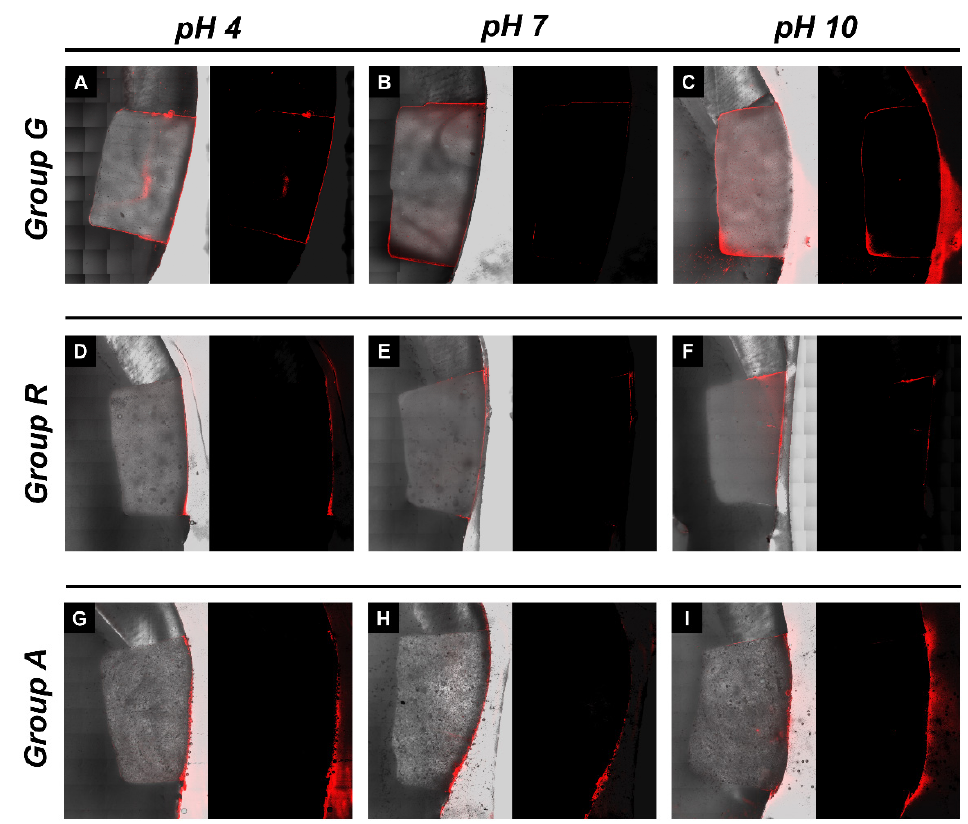
Figure 3. Microleakage analysis of the experimental groups. Representative images of confocal laser scanning microscopic photograph showing the rhodamine B dye penetration. ( A – C ) Representative images of pH 4, pH 7 and pH 10-stored giomer restorations, respectively; ( D – F ) pH 4-, pH 7- and pH 10-stored RMGI restorations, respectively; ( G – I ) pH 4-, pH 7- and pH 10-stored alkasite restorations, respectively.